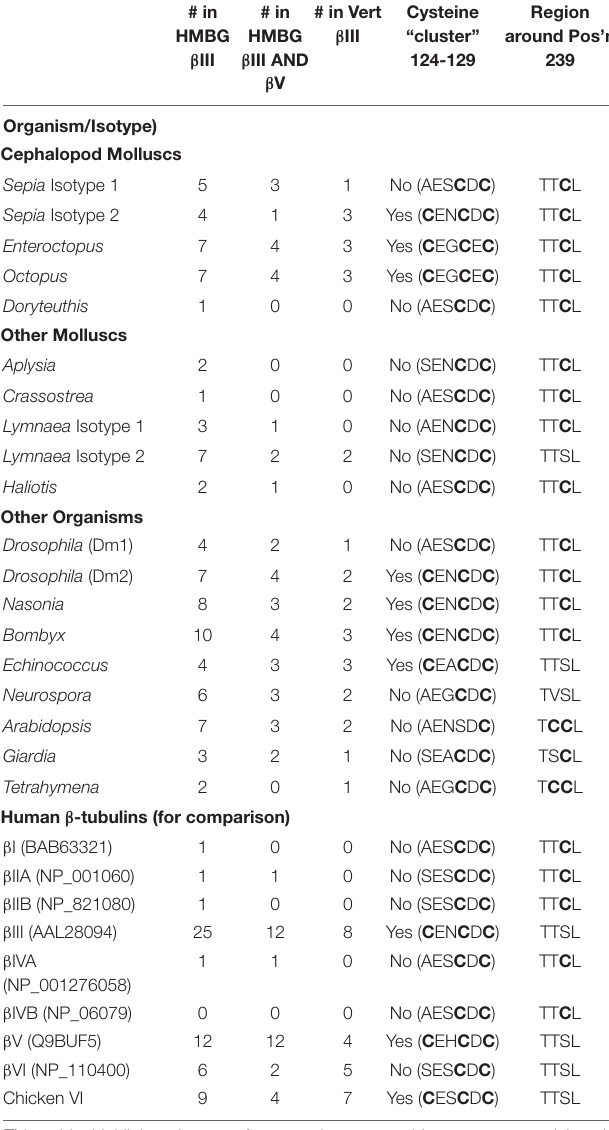
TABLE 5 | Number of Positions That Are Conserved in Vertebrate β III or Both β III and β V that Are Also Conserved in Non-Vertebrate β